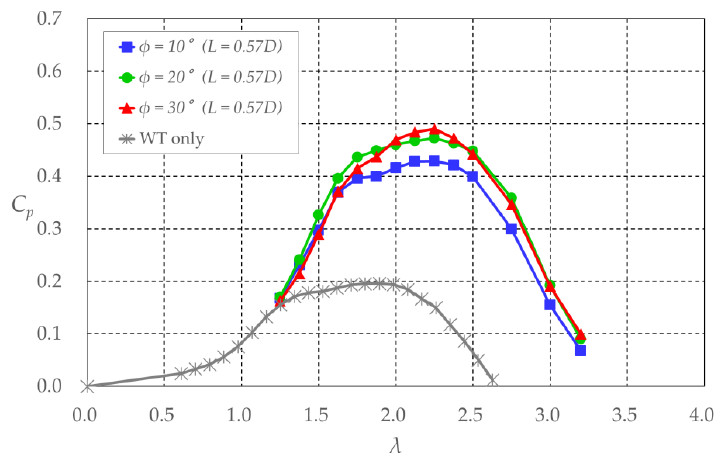
Figure 7. Power coefficient C p of wind turbines with and without a wind lens vs. tip speed ratio λ (diffuser length: L = 0.57 D m). Refer to Figure 2 for D , and L .